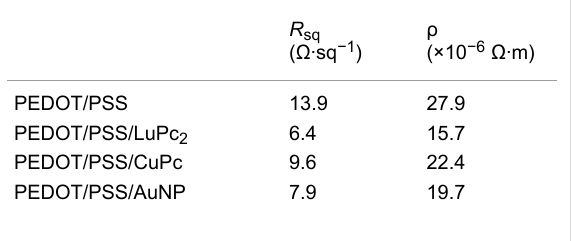
Table 1: Square resistance ( R sq ) and conductivity ( ρ ) of the PEDOT/ PSS and PEDOT/PSS/EM